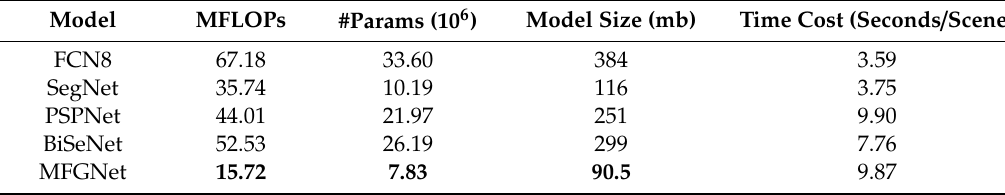
Table 4. E ffi ciency comparison of the di ff erent